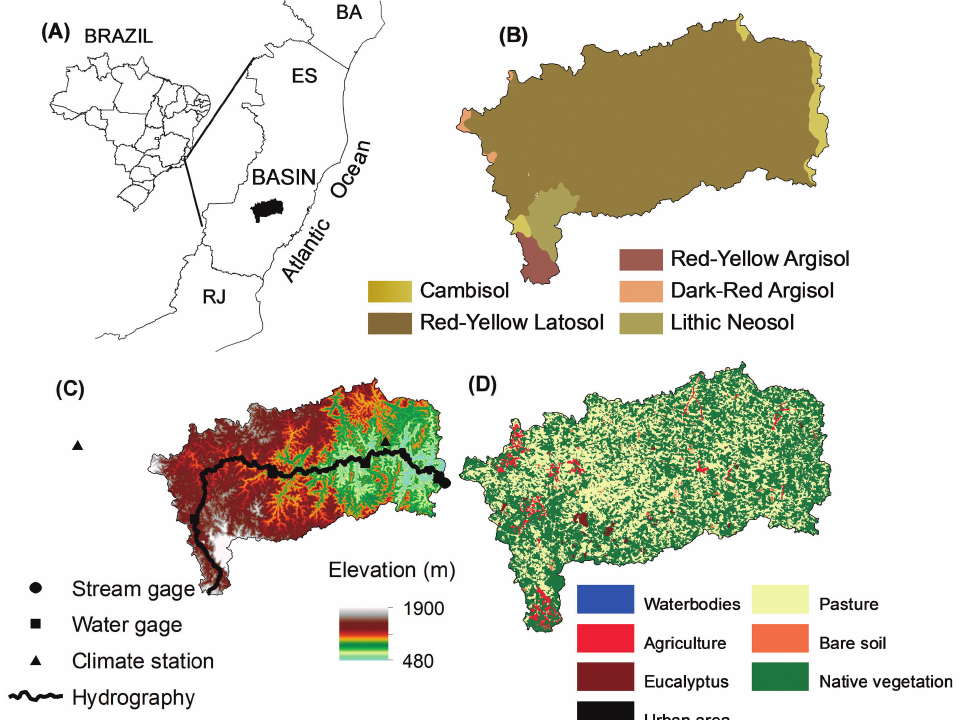
Figure 1. Map of localization (a), soil type (b), altitude (c), and land use and soil cover (d) of the Galo creek